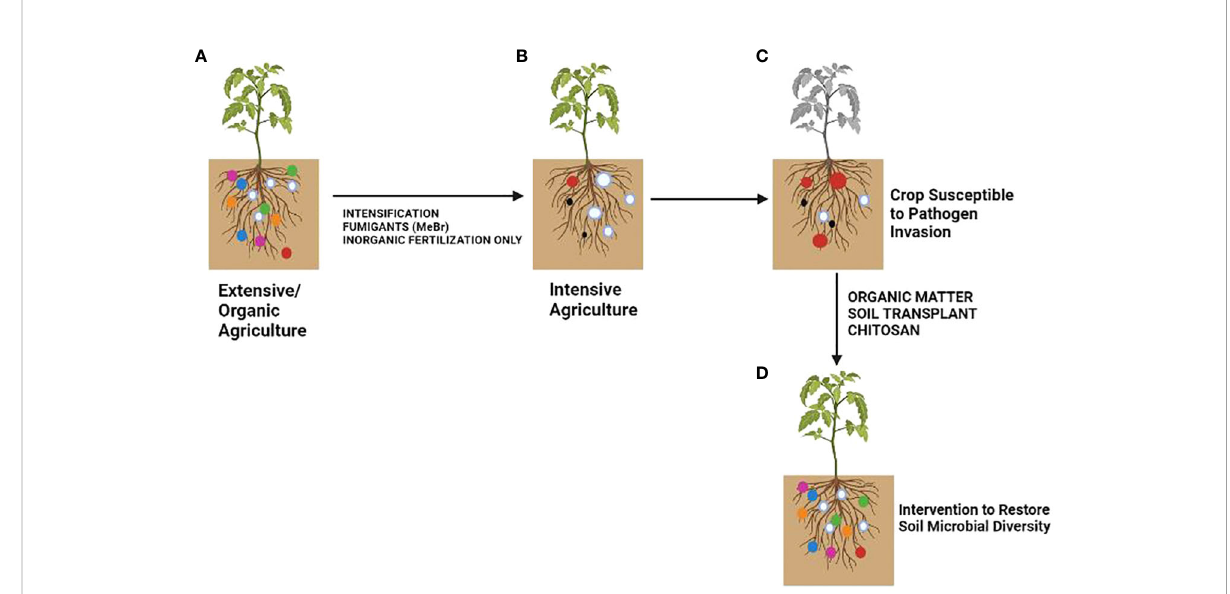
FIGURE 2 Effect of soil microbiota modi fi cation by agricultural practices on crop disease outcome. (A) Extensive/Organic farming, (B) Intensive farming, (C) Crops susceptible to pathogen invasion, (D) Soil after microbiota restoration. The colored circles represent different soil microbial taxa. The size represents the amount of inoculum. Pathogenic taxa are indicated by red circles. Modi fi ed from Bakker et al.